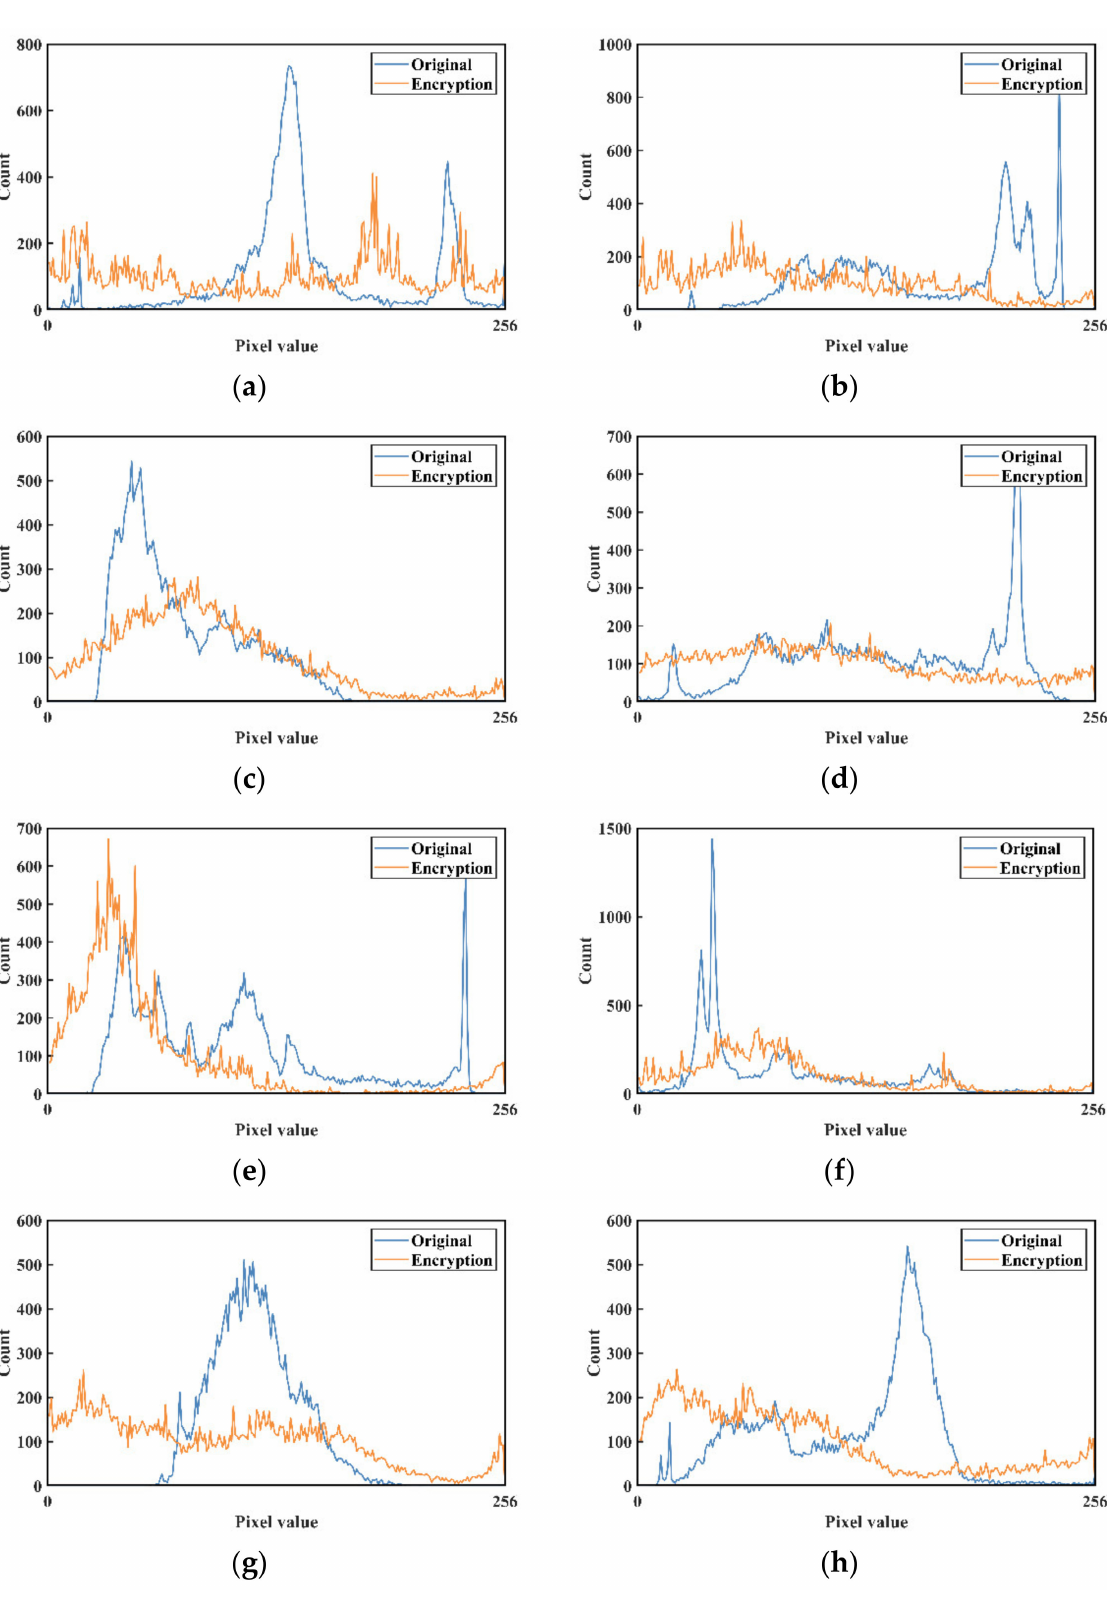
Figure 7. Histogram of original and encrypted frame. ( a ) container, ( b ) foreman, ( c ) salesman, ( d ) mobile, ( e ) carphone, ( f ) news, ( g ) city, ( h )